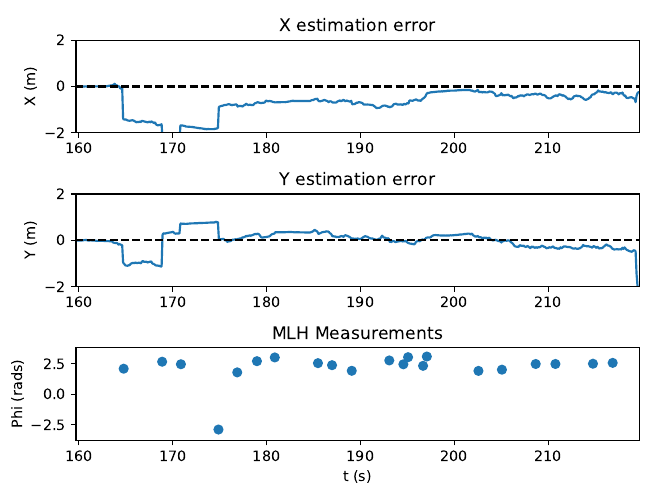
Figure 11. Estimation error during the quadrotor lighthouse localization experiment. The quadrotor is performing rotations and receiving bearing measurements from sensor nodes.